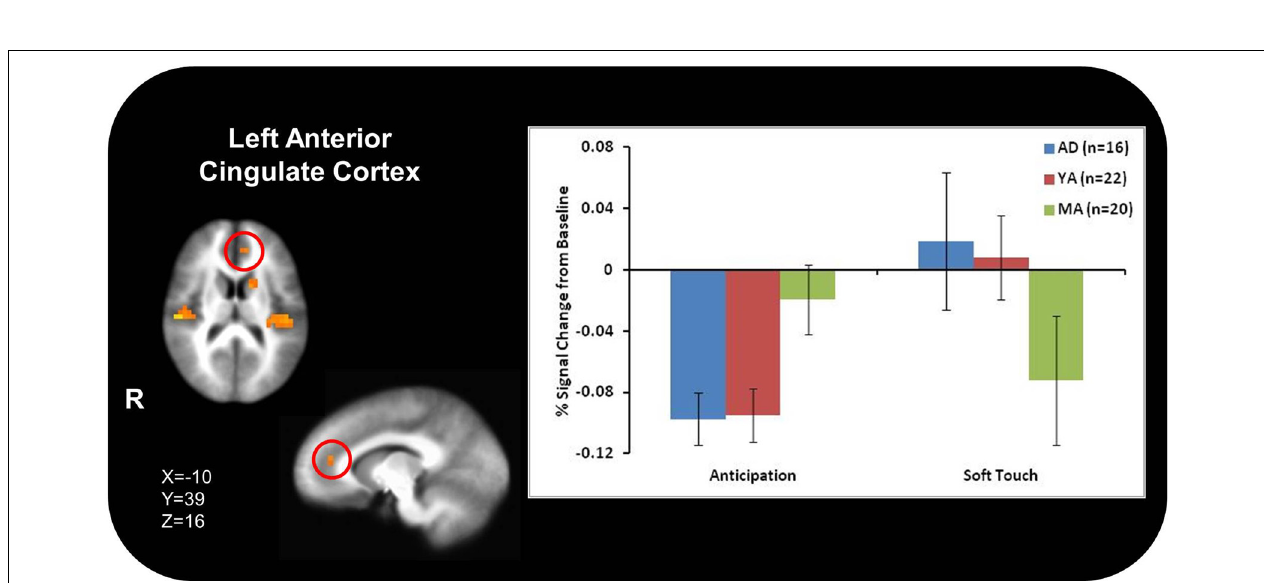
FIGURE 6 | In the left dorsal anterior cingulate (ACC), adolescents (AD) and young adults (YA) displayed comparable deactivation during anticipation, where as during the soft touch they